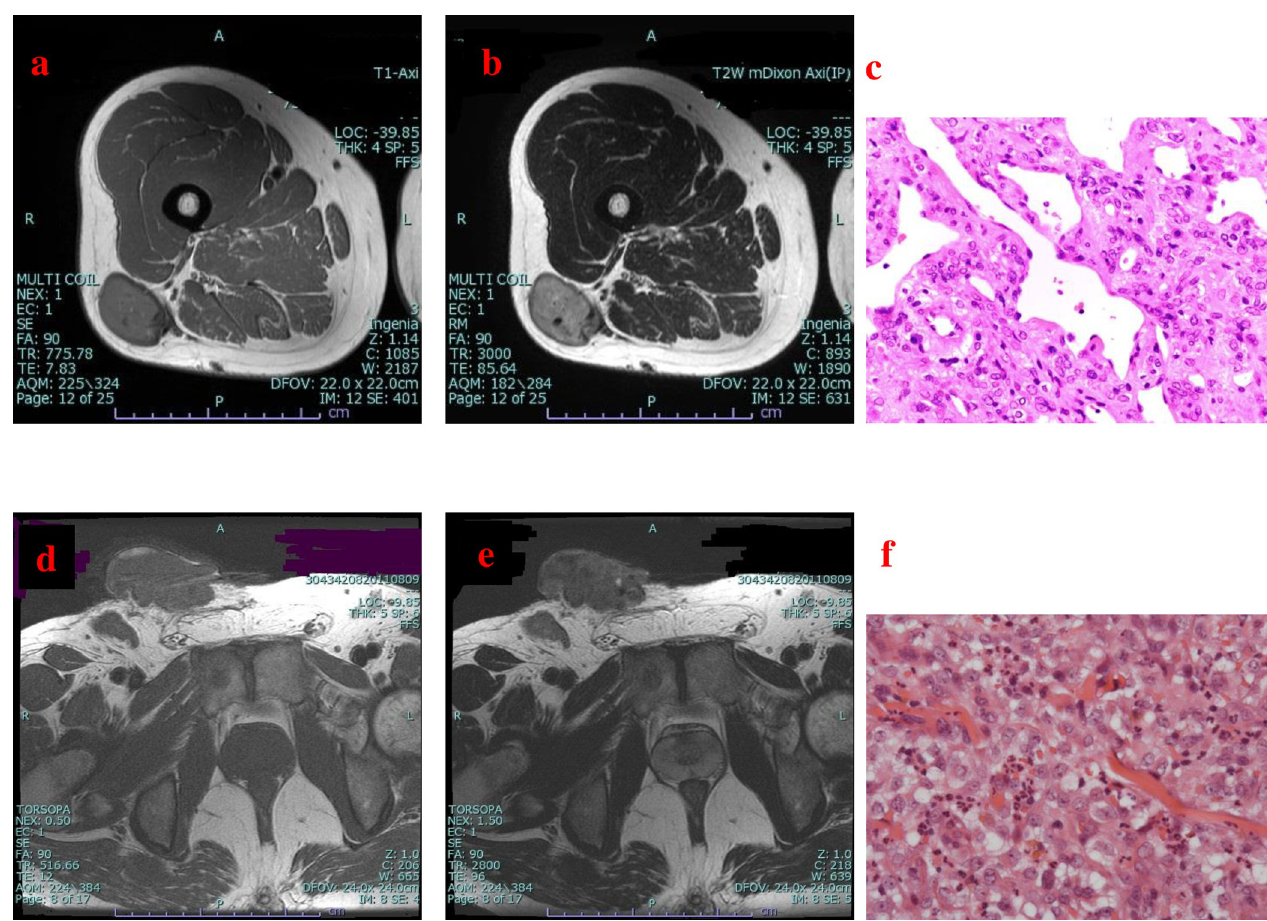
Fig 2. Representative cases. (a, b, c) Magnetic resonance imaging (MRI) findings for a superficial lesion in the right thigh in a 44-year-old woman. Axial T1-weighted (a) and T2-weighted (b) images reveal that the lesion did not invade the skin. Pathological examination of the specimen confirmed a solitary fibrous tumor (c) (hematoxylin-eosin staining; magnification × 400). (d, e, f) MRI findings for a superficial lesion in the right inguinal region in a 46-year-old man. Axial T1-weighted (d) and T2-weighted (e) images reveal that the lesion invaded the skin. Pathological examination of the specimen confirmed epithelioid sarcoma (f) (hematoxylin-eosin staining; magnification × 400).